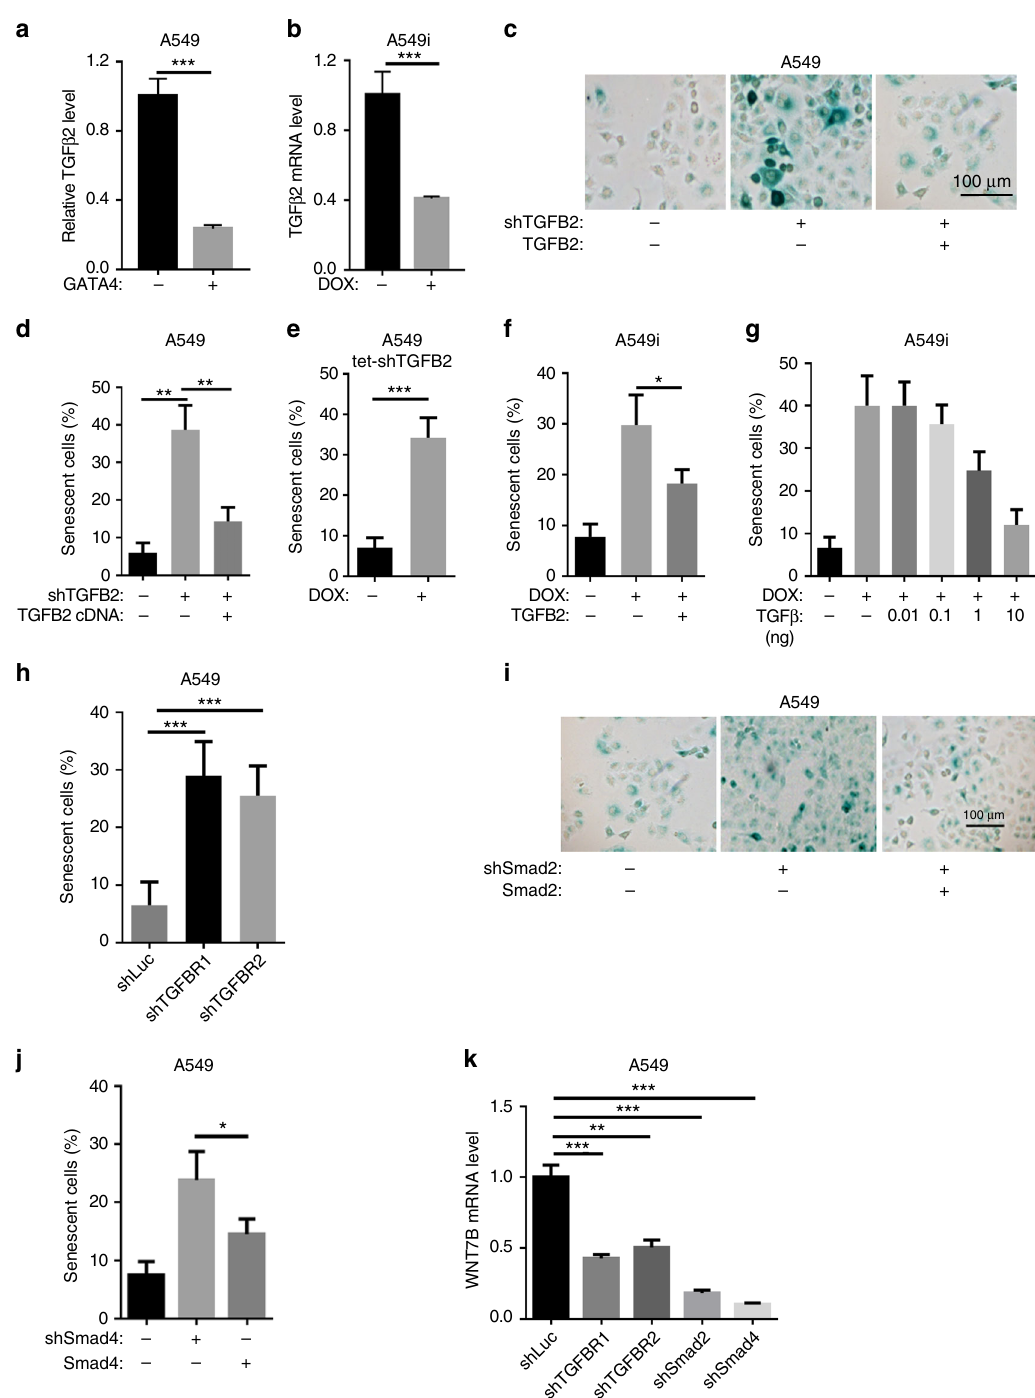
Fig. 4 TGF- β 2 mediates GATA4-induced senescence upstream of Wnt-7b. a and b qRT-PCR analysis of TGFB2 expression in GATA4 overexpressing A549 cells through lentivirus infection ( a ) or Doxycycline treatment of A549i cells ( b ) ( n = 3 per group). c β -Galactosidase staining of A549 cells with TGFB2 knockdown (middle panel) and rescued by shRNA-resistant TGFB2 . d Statistics of c ( n = 3 per group). e β -Galactosidase staining of A549 expressing Dox- inducible shRNA targeting TGFB2 ( n = 3 per group). f β -Galactosidase staining of A549i in the absence or presence of 2 μ g/mL of Dox and rescued by TGFB2 expression ( n = 3 per group). g β -Galactosidase staining of A549i cells in the absence or presence of 2 μ g/mL of Dox and rescued with recombinant TGF- β protein at indicated concentration ( n = 3 per group). h β -Galactosidase signal in A549 cells knockdown of TGFBR1 and TGFBR2 ( n = 3 per group). i β - Galactosidase signal of A549 cells with SMAD2 knockdown (middle panel) and rescued by shRNA-resistant SMAD2 (right panel). j β -Galactosidase staining of A549 cells with SMAD4 knockdown (middle panel) and rescued by shRNA-resistant SMAD4 (right panel) ( n = 3 per group). k WNT7B expression level in A549 cells with knockdown of TGFBR1 , TGFBR2 , SMAD2 , or SMAD4 , respectively ( n = 3 per group). Bars are represented as mean ± SEM of the indicated number ( n ) of repeats. *P < 0.05, **P < 0.01, and ***P < 0.001 by Student ’ s t